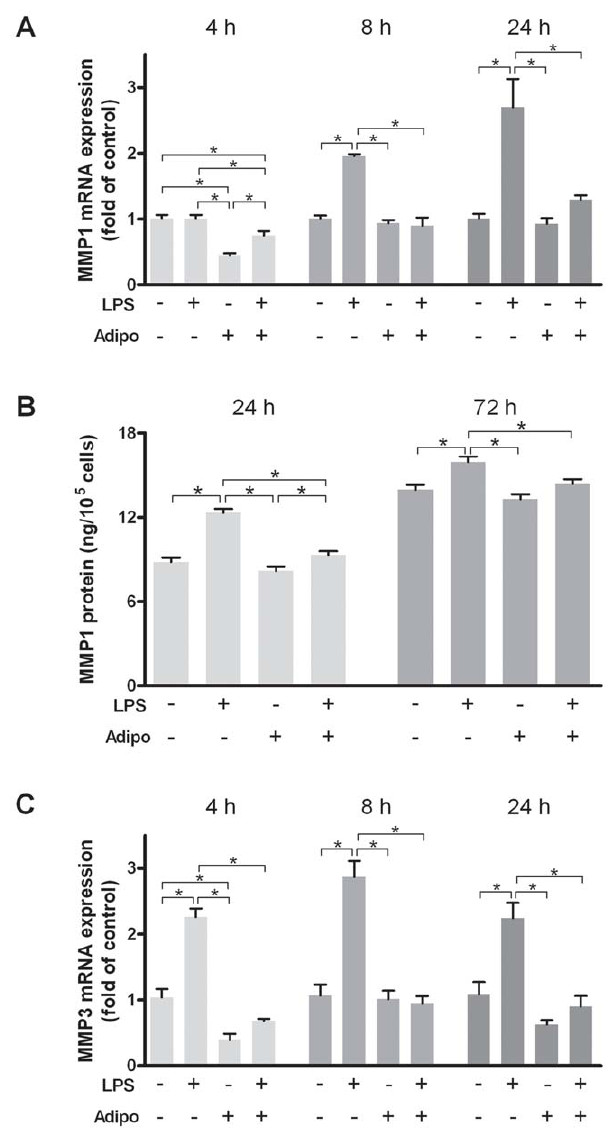
Figure 5. Interactions of lipopolysaccharide and adiponectin on matrix metalloproteinases. Effects of lipopolysaccharide (LPS; 2 m g/ml) and/or adiponectin (Adipo; 1 m g/ml) on the mRNA expression of MMP1 (A) and MMP3 (C) at 4 h, 8 h, and 24 h and on the protein level of MMP1 (B) in supernatants at 24 h and 72 h. Mean 6 SEM; n=6; * p , 0.05 difference between groups.